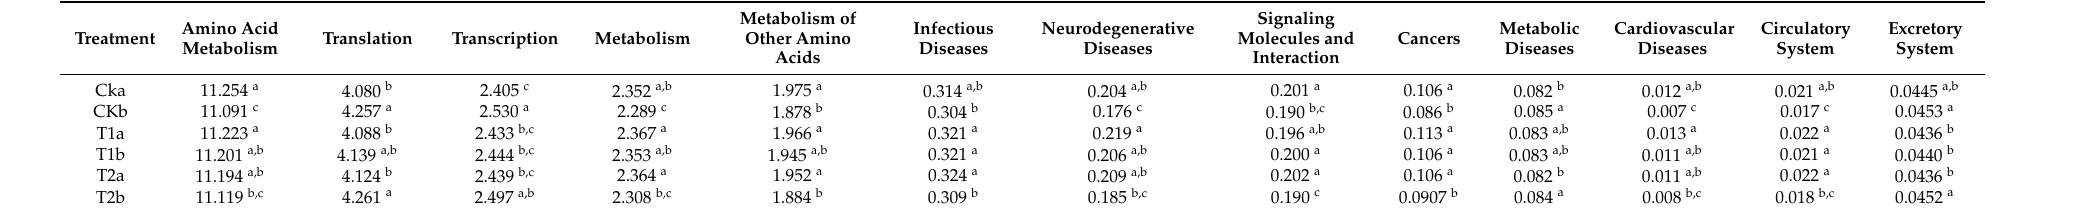
Table 5. Relative abundances of sub-functions of bacterial community of each